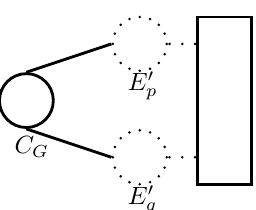
Figure 8. We can make a G-string by wrapping a D3-brane on the cycle C G in eq. (4.14). It is viewed as a linear combination of E and E 0 -strings, which can be attached to two E 0 -strings. This G-string will be needed in global construction of (1,0) D and E type